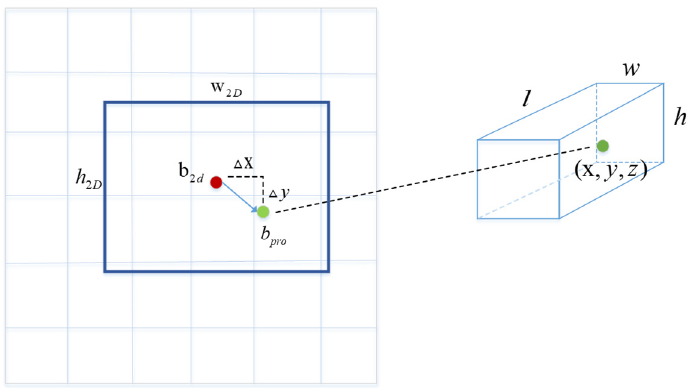
Figure 3. Information fusion process with attention mechanism of 2D region of interest and region pseudo ‐ lidar.